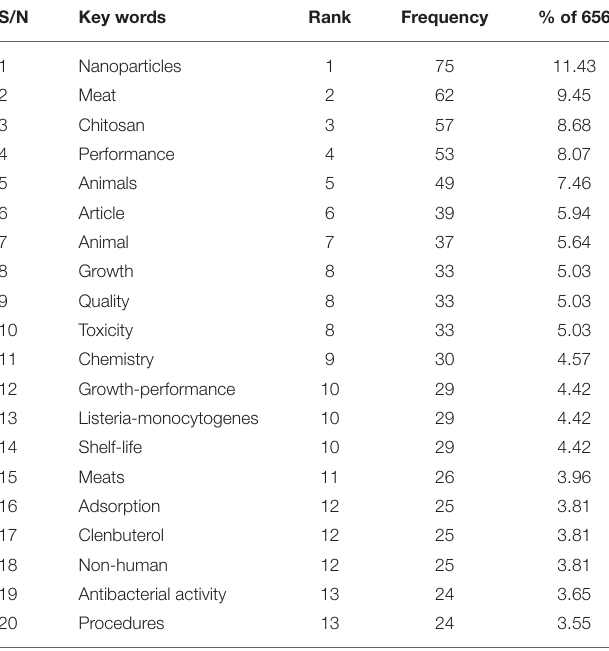
TABLE 4 | Top 20 most frequently used words by researchers in the field of meat production through nanotechnology.